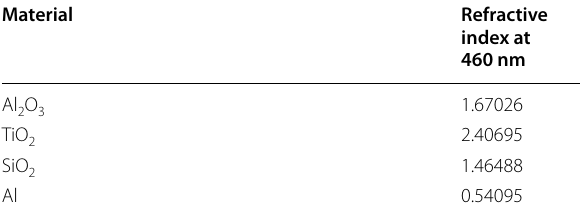
Table 1 Refractive indices and extinction coefficients of